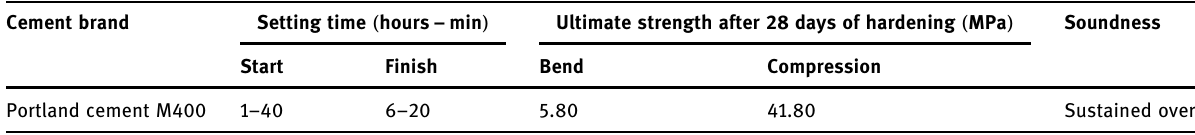
Table 2: Physical - mechanical properties of Portland cement Cement brand